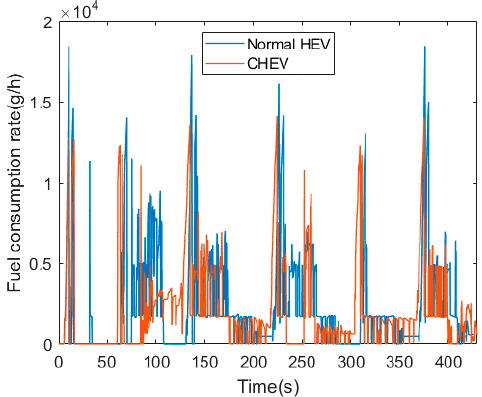
Figure 11. Fuel consumption rate.